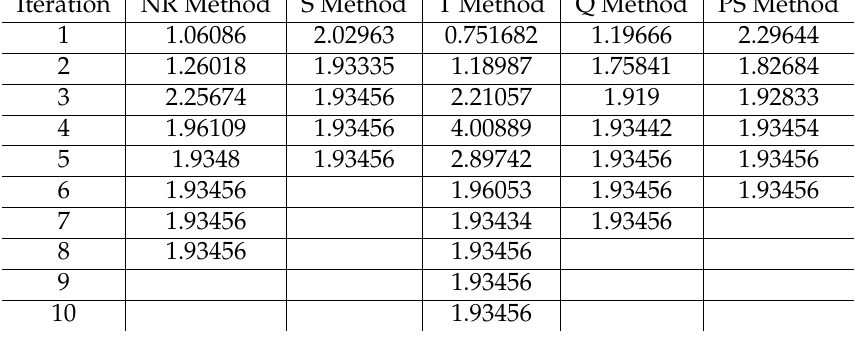
Table 7. Numerical results for the Equation (21)